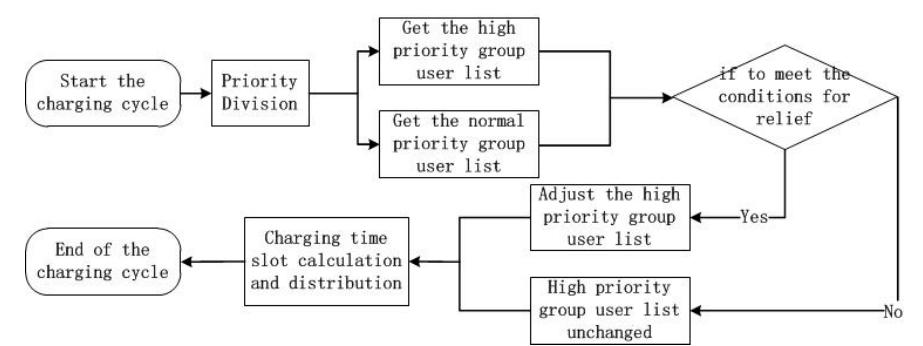
Figure 2. Dynamic charging queuing algorithm flow chart.